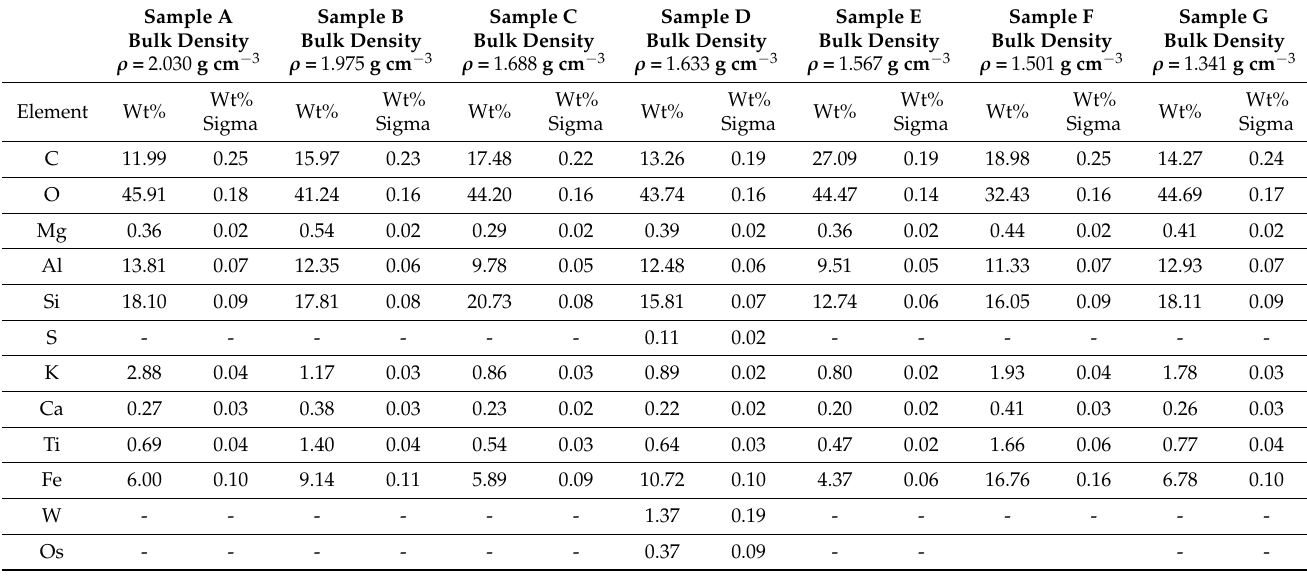
Figure 5. EDX electron image, spectrum and wt% (insets) of sample G. Table 2. Summary of EDX elemental composition in Weight percent of the Samples.